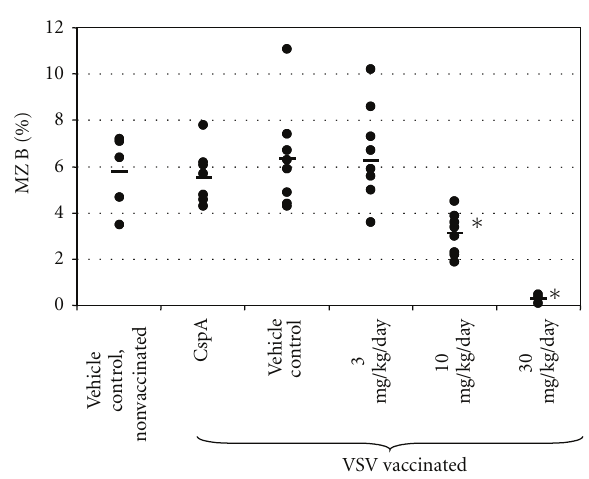
Figure 3: Marginal zone B cells in mice dosed with RO4929097 for 27 days. For each mouse the percentage of MZ B cells ( = IgM + /B220 + /CD21 high /CD23 low ) in the leukocyte gate is shown. Dots represent individual mice. - = average per group. ∗ = statistically significant di ff erence to vehicle control ( P < 0 . 01). CspA = cyclosporin A. n = 5–8mice/sex/group.